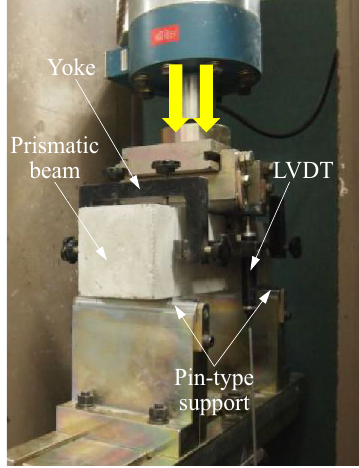
Fig. 3 Four-point flexural test (ASTM C1609).